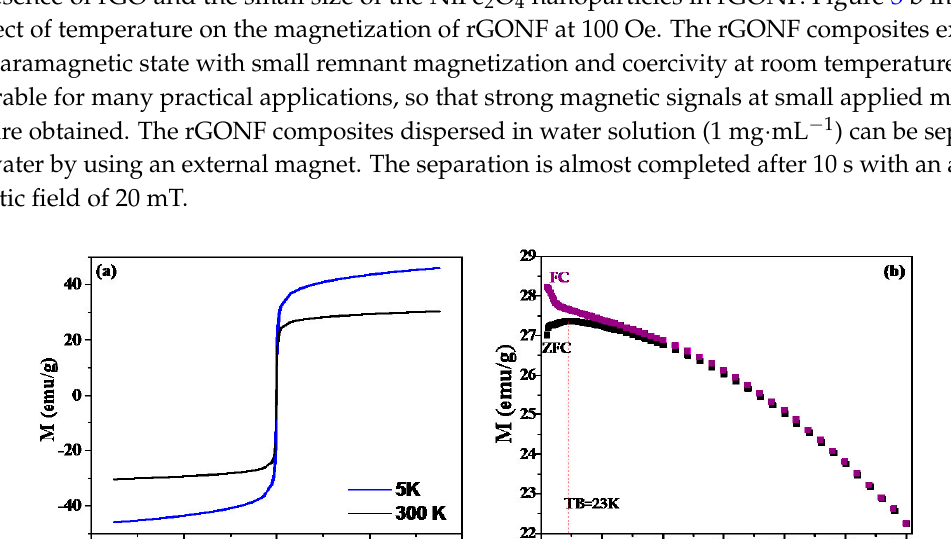
Figure 3. Magnetic measurement of rGONF using a SQUID magnetometer. The trend of magnetization (M) of rGONF with external magnetic field ( a ) and the temperature at 100 Oe ( b ).